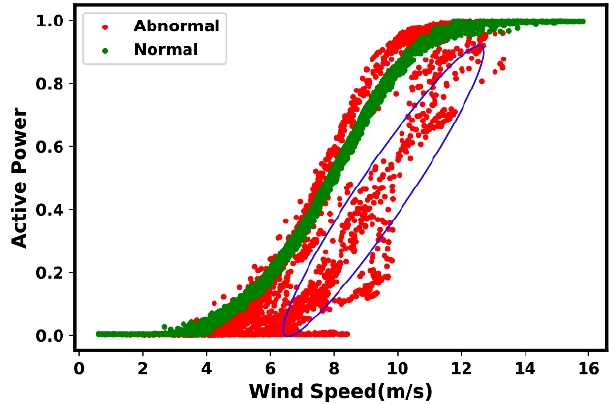
Figure 10. Type 5: Icing/Debris Build-up on Blades.